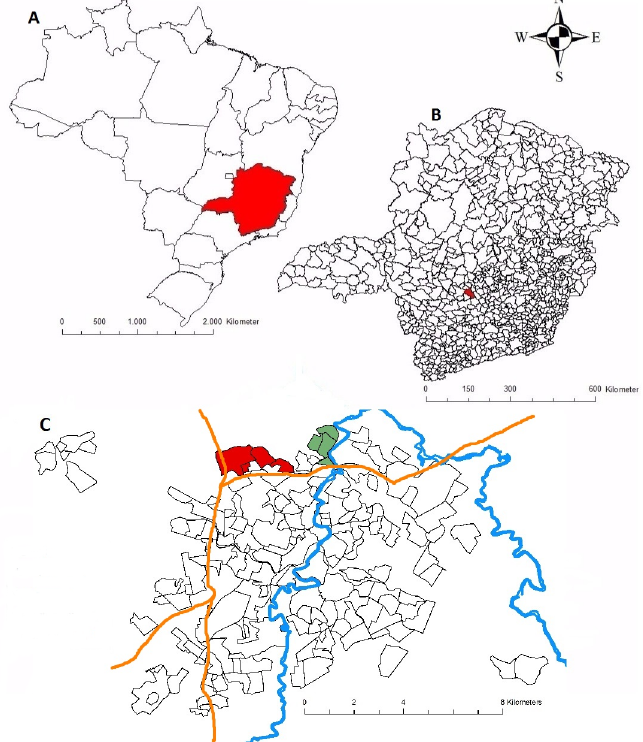
Fig 1. Study setting: a. Brazil, the State of Minas Gerais appearshighlighted;b. the State of Minas Gerais, the city of Divino´polis appearshighlighted;c. Divino´polis, the two areas of capture appearhighlighted(area A– control—in red; area B–intervention—in green); River in blue; Highwayin orange.